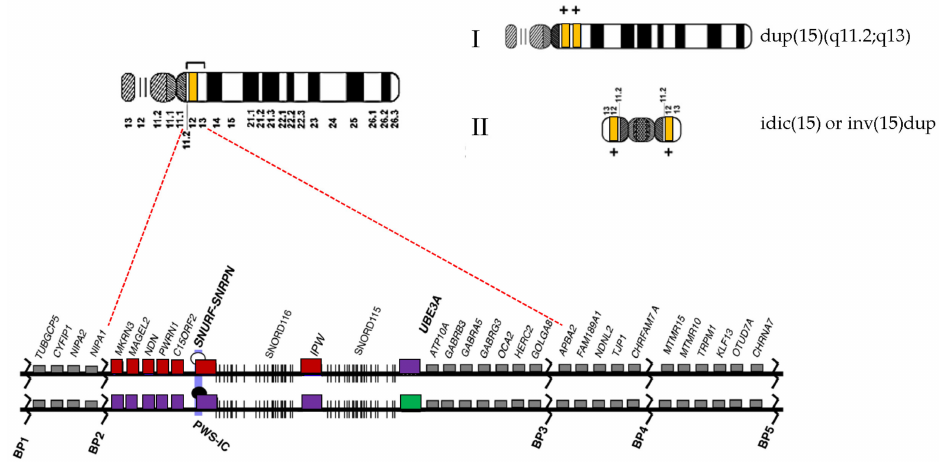
Figure 2. Map of 15q11.2-q13 region. ( I ) Interstitial duplication 15q11.2-q13 and ( II ) idic(15) or inv(15)dup. Gene distribution between breakpoint (BP) 1 and BP5 on the proximal 15q region. 15q11.2-q13.1 region is located between BP2 and BP3. Genes displayed by red and green boxes are imprinted and expressed from paternal and maternal alleles, respectively. Violet box indicates silenced allele. Gray box marks genes expressed from both parental alleles. BP, break point; PWS, Prader–Willi syndrome; IC, imprinting